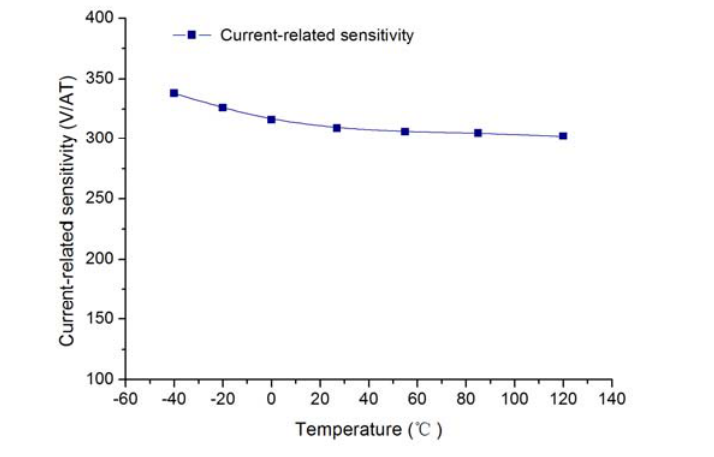
Figure 9. Measurement of the current-related sensitivity versus